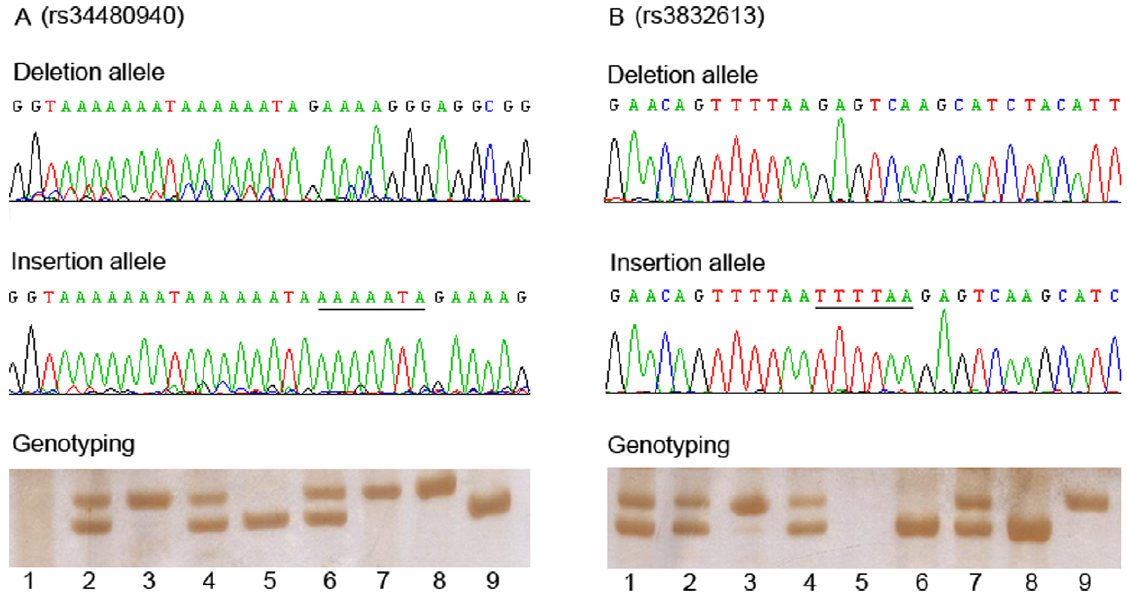
Figure 1. Example sequencing and genotyping output for the two BRM Indel polymorphisms. The upper and middle panels showed the sequence of deletion and insertion allele, respectively. The underlined base-pairs indicate the inserted sequences. The lower panel displays an example of the genotyping assay results. For rs34480940 (Figure 1A), lane 5 and 9, del/del genotype; lane 2, 4 and 6, ins/del genotype; lane 1, negative control; remaining lanes, ins/ins genotype. For rs3832613 (Figure 1B), lane 3 and 9, ins/ins genotype; lane 3 and 9, del/del genotype; lane 5, negative control; remaining lanes, ins/del genotype.